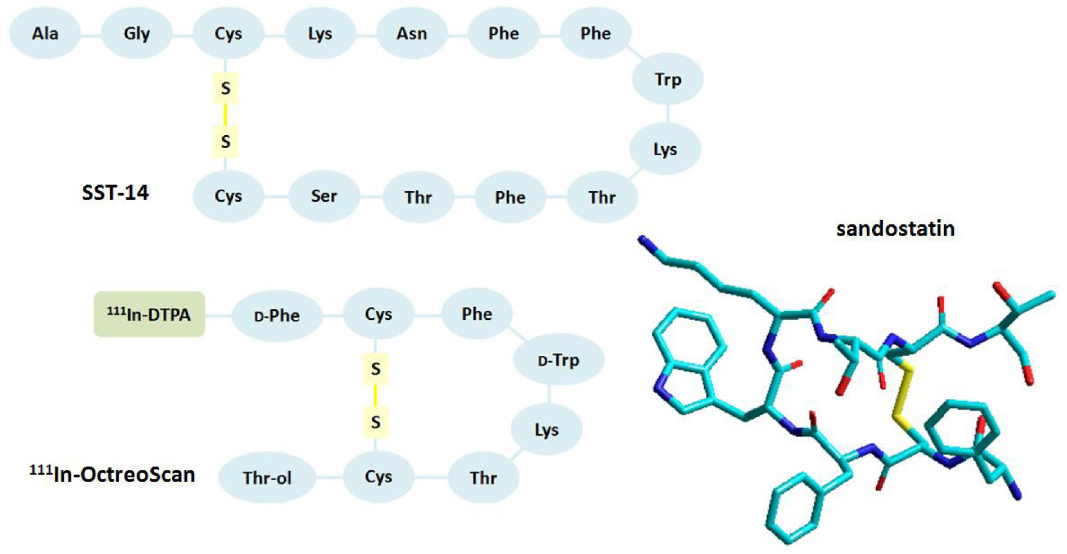
FIGURE 3 - Amino acid residue sequences for SST-14 and 111 In-OctreoScan (adapted from Okarvi, 2008), and the 3D structure of sandostatin retrieved from PDB entry code 1SOC (Melacini, 1997). The hydrogen atoms not shown in the 3D-model. Carbon atoms are shown in light blue, nitrogen in dark blue, oxygen in red, and sulfur in yellow.